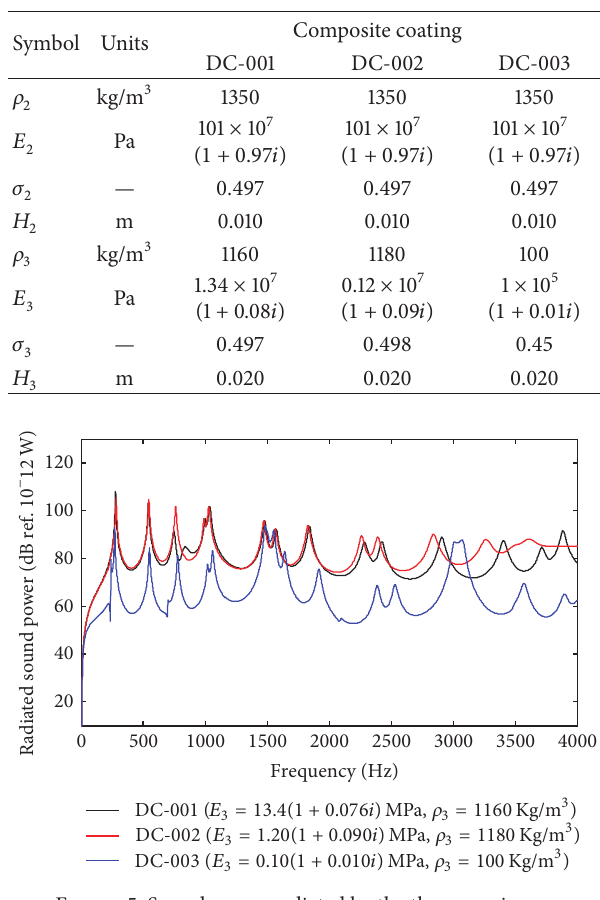
Figure 5: Sound power radiated by the three